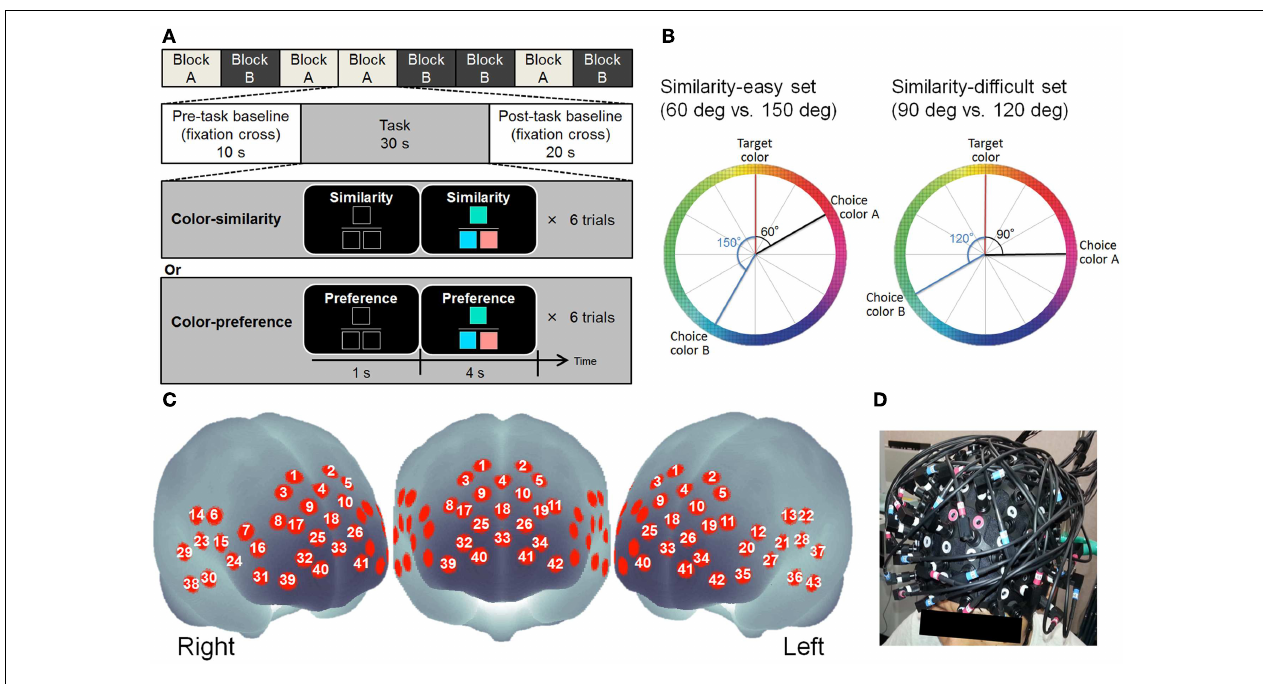
displays examples of color combinations of the similarity-difficult set.The degrees from target color to choice color signify the color similarity. (C) Approximate location of the NIRS channel positions in MNI space. (D) NIRS probe